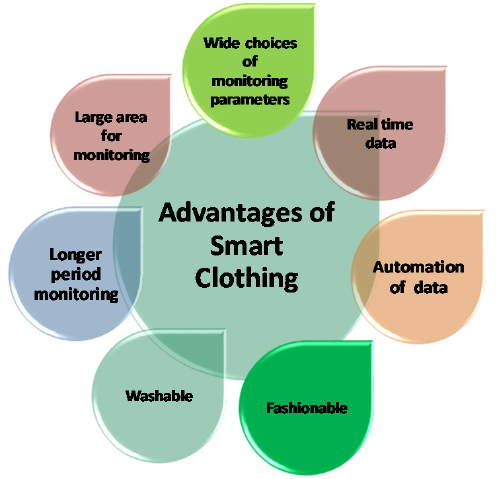
Figure 4. Advantages of smart clothing.